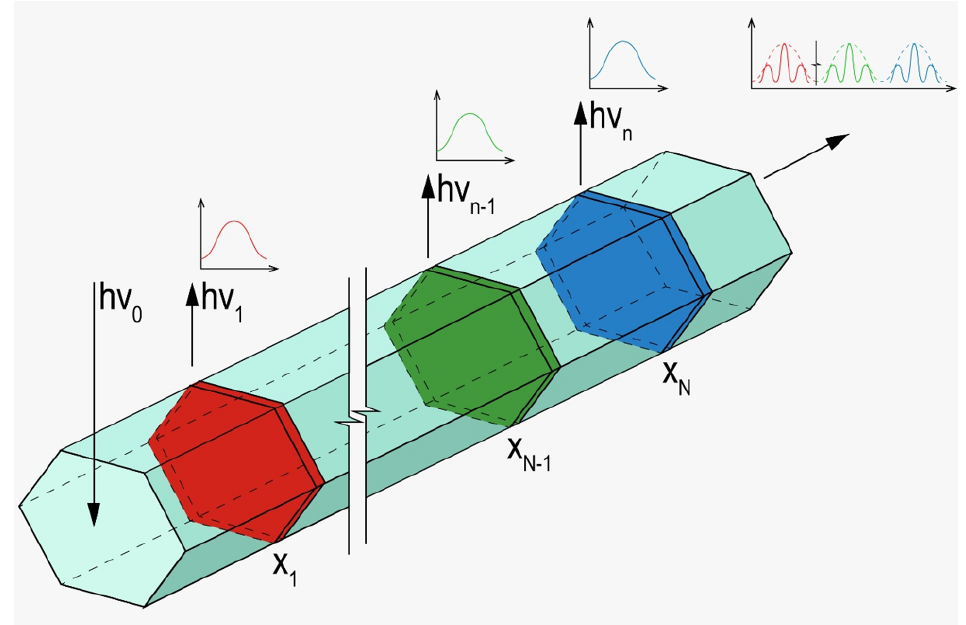
Figure 6. Schematics of the heterostructured NW with multiple NDs characterized by the corre- sponding PL emission with a characteristic photon energy h (cid:2021) k . h (cid:2021) 0 —excitation. The obtained results shed light on new pathways for advanced photonic applica- tions. For example, the spectrum of the PL emission outcoupled at the edge of an NW, schematically shown in Figure 6, can be controlled via the variation of the excitation wave- length. To obtain the spectrally variable emitter based on this approach, NDs with differ- ent bandgaps should be precisely positioned inside an NW so that the shift in the excita- tion wavelength leads to a spatial shift of the NW mode maxima, followed by the switch